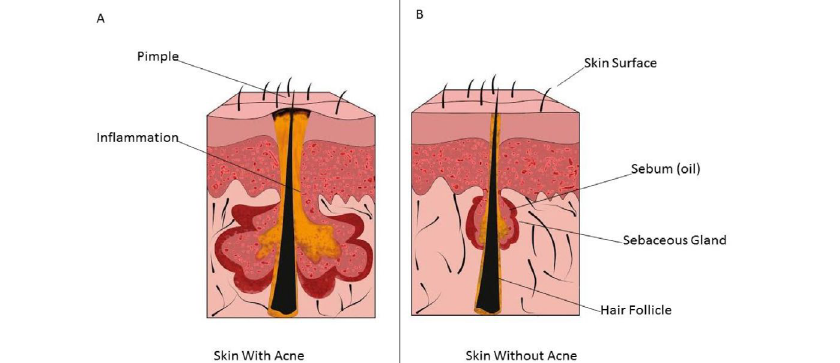
Fig. 1. Anatomic illustration of acne development in skin. A (skin with acne): development of acne due to increasing in sebum pro- duction in sebaceous glands that cause pilosebaceous canal obstruction, followed by inflammation and blackhead comedone, B (skin